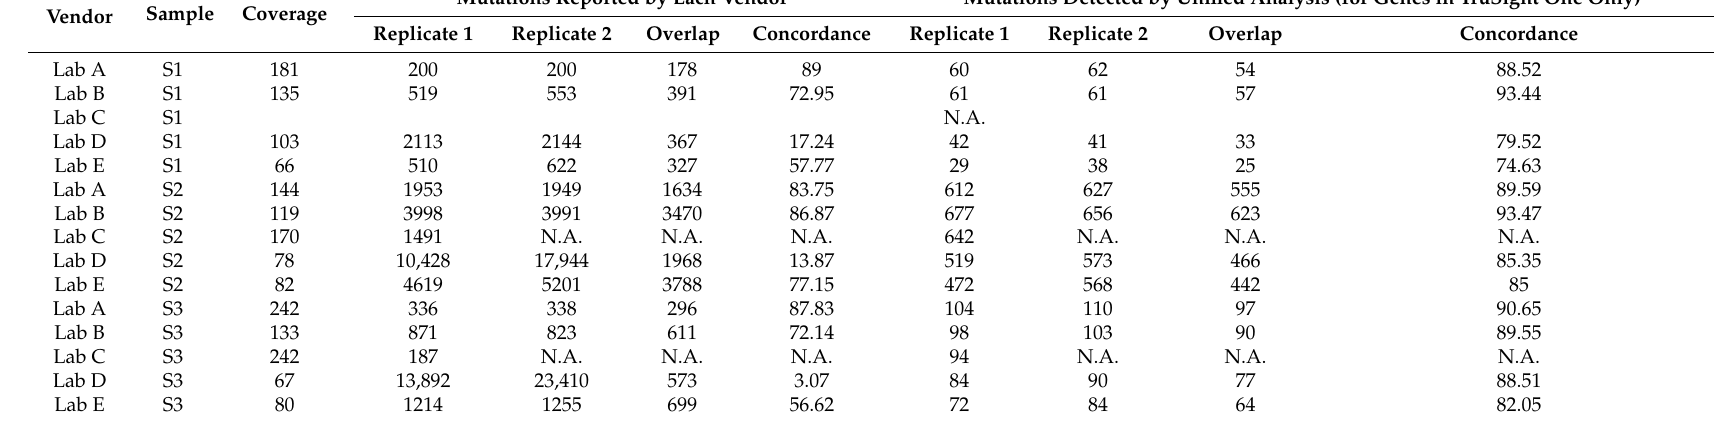
Table 1. Whole exome sequencing (WES) performance for all 5 vendors. Concordance is calculated by the number of shared mutations among the two replicates divided by the average of the number of mutations reported by the two replicates. Sample S1 data is not available for Lab C (as N.A. in